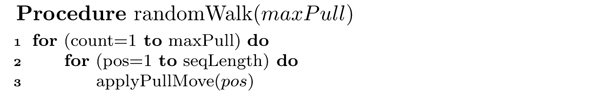
Random-walk algorithm. Spiral Search framework: pseudocode of Procedure randomWalk.